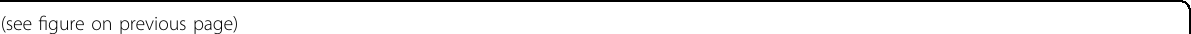
viability was measured via the MTT assay. b The combined effects of prazosin (20 μ M) and sorafenib (5 μ M) in HuH-7 R cells were measured via the MTT assay. Combination index (CI) plots were generated using CompuSyn (CI < 1, synergistic; CI = 1, additive; CI > 1, antagonistic). Fa effect under each concentration, CI combination index. c Combined effect of prazosin and sorafenib on the tumorigenic ability of HuH-7 R cells. HuH-7 R cells were treated with prazosin and sorafenib at the indicated concentrations for 14 days, and the colony-formation assay was performed. d Synergistic effect of prazosin and sorafenib on apoptosis in resistant cancer cells. HuH-7 R cells were treated with prazosin and sorafenib at the indicated concentrations, followed by staining with Hoechst 33342, and the number of apoptotic cells was quanti fi ed. e Effect of the combination of prazosin and sorafenib on wound healing in HuH-7 R cells. The micrographs show cells that had migrated into the gap 0 and 12 h after the removal of the insert. f Synergistic effect of prazosin and sorafenib on the invasion of HuH-7 R cells examined via the Transwell assay. Cells in the central fi eld of